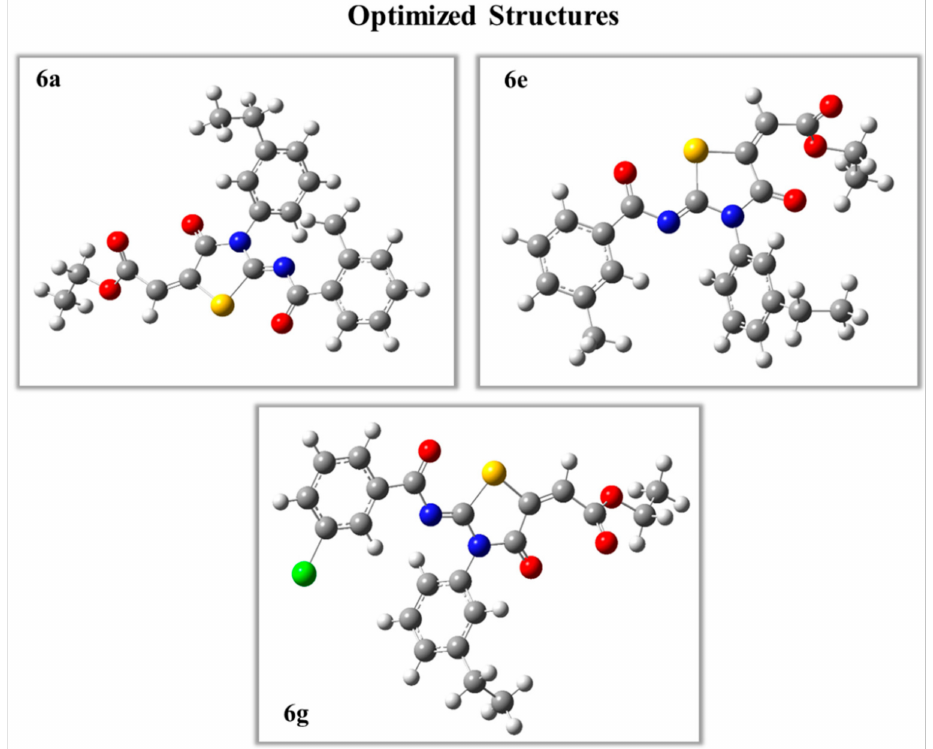
Figure 4. Illustration of optimized structural geometries of compound 6a , 6e , and 6g